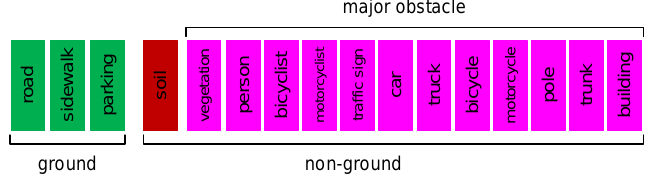
Figure 8. Objects included in “ground” and